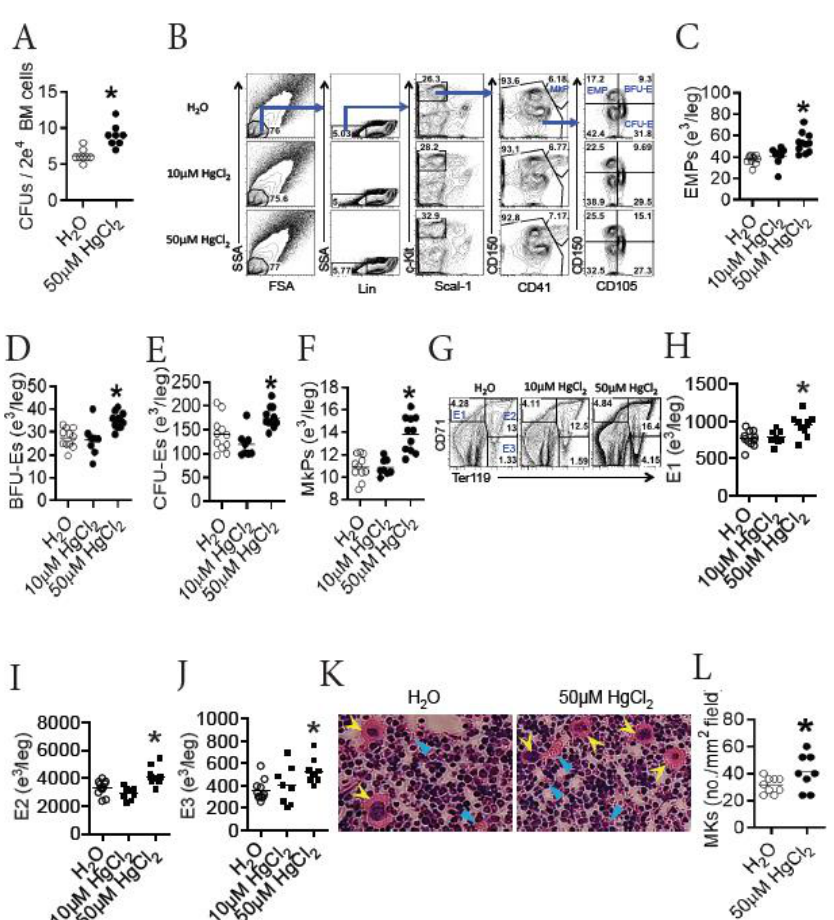
Figure 2. HgCl 2 increases the development of erythrocytes and megakaryocytes/platelets in the BM of B10.S mice. B10.S mice were treated with 10 µ M or 50 µ M HgCl 2 for 4 w, and the potential of BM cells to generate CFU-Es as well as erythro-megakaryopoiesis in the BM were measured thereafter. ( A ) The number of CFU-Es derived from BM cells ex vivo. ( B ) Representative flow plots for EMPs, BFU-Es, CFU-Es and MkPs in the BM. ( C ) Quantification of EMPs in the BM as indicated in ( B ). ( D ) Quantification of BFU-Es in the BM as indicated in ( B ). ( E ) Quantification of CFU-Es in the BM as indicated in ( B ). ( F ) Quantification of MkPs in the BM as indicated in ( B ). ( G ) Representative flow plots for erythroblasts (E1, E2, and E3) in the BM. ( H ) Quantification of E1 in the BM as indicated in ( G ). ( I ) Quantification of E2 in the BM as indicated in ( G ). ( J ) Quantification of E3 in the BM as indicated in ( G ). ( K ) Representative histological images for H&E staining of BM sections from B10.S mice treated with 50 µ M HgCl 2 or the control. Yellow arrows and blue arrows point to megakaryocytes and RBCs, respectively. ( L ) Quantification of MK for each mm 2 of the BM field as indicated in K. Each dot represents one mouse, and a total of 8 to 11 mice were used for each group. Asterisk indicates a significant difference compared to the counterpart control group. p < 0.05 was considered as the level of significant difference.